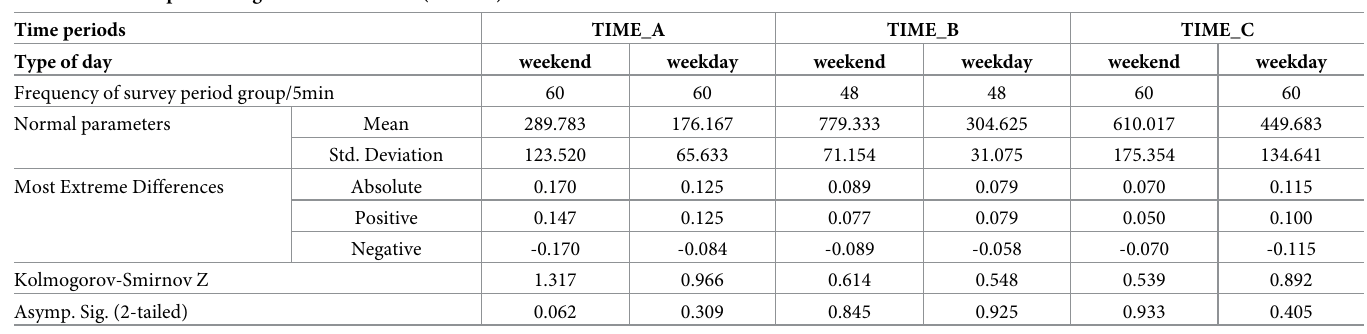
Table 1. One-Sample Kolmogorov-Smirnov Test (Arrivals).